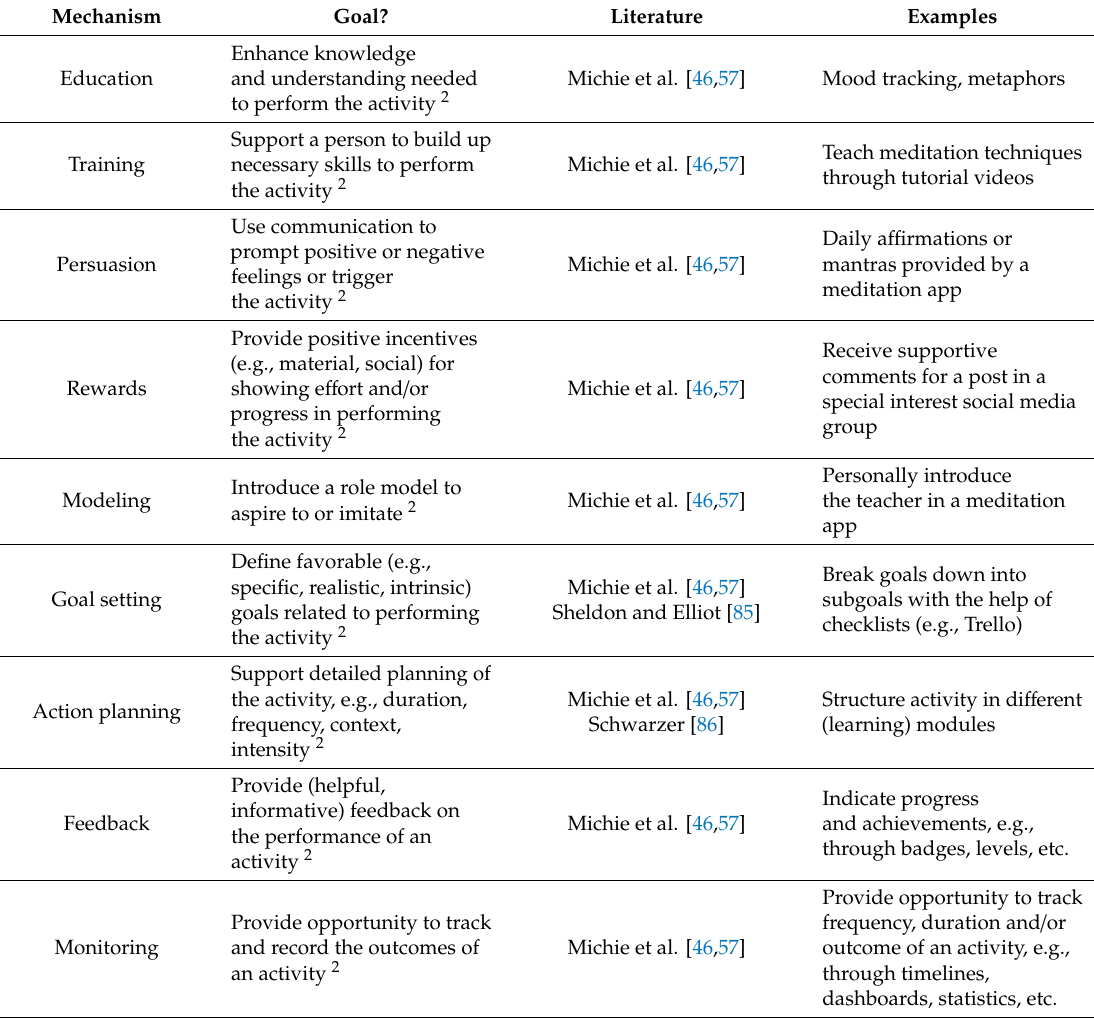
Table 2. Mechanisms rooted in behavior change and positive psychology literature as well as in empirical findings from Wiese et al.